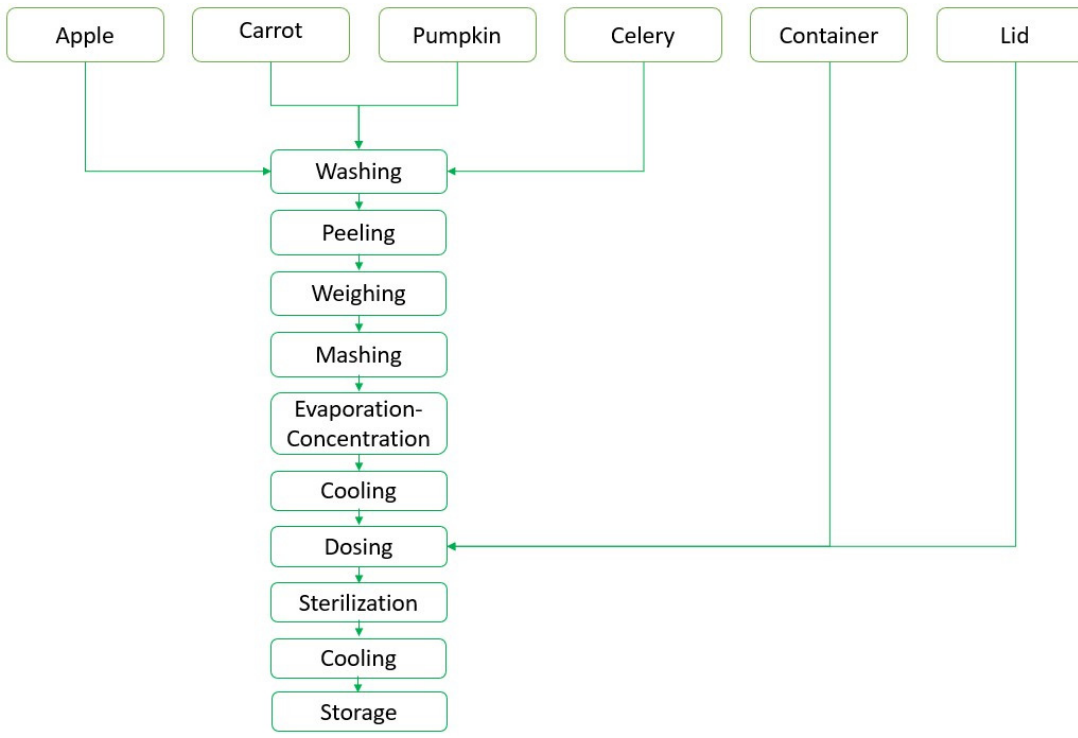
Figure 2. Flow chart of the processing steps of puree samples.